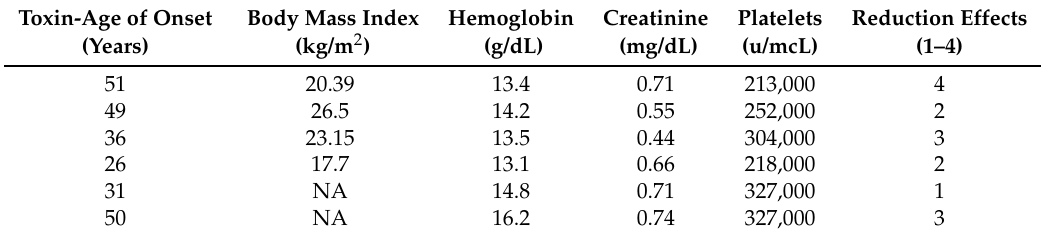
Table 1. Example of continuous and categorized features available in the clinical